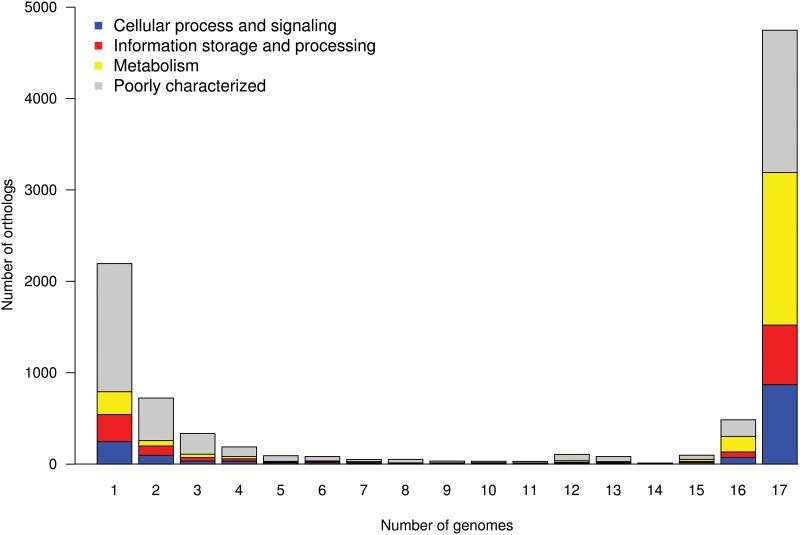
Distribution of orthologs in genomes.Number of orthologs as a function of the number of genomes they are in, broken down by super-functional categories using COG database.